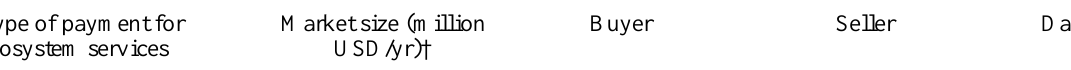
Table 1. Estimates of market size, buyers, and sellers in various market segments of payment for ecosystem services (PES) as of 2009. See text for explanations of categories and market